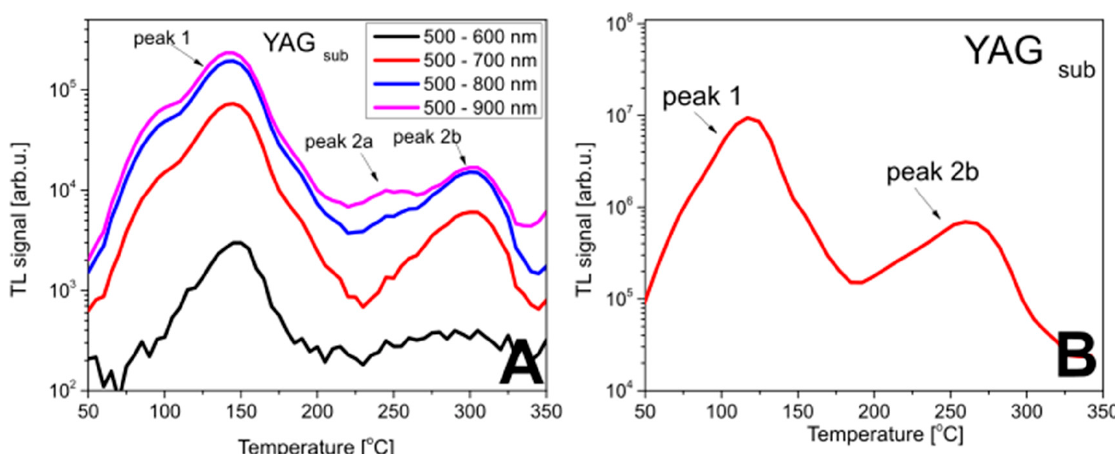
Figure 4. TL glow curves of the YAG substrate after irradiation with 90 Sr/ 90 Y measured with the Ocean Optics QE Pro 00689 spectrometer ( panel A ) and with the TL reader utilizing a CCD camera ( panel B ).